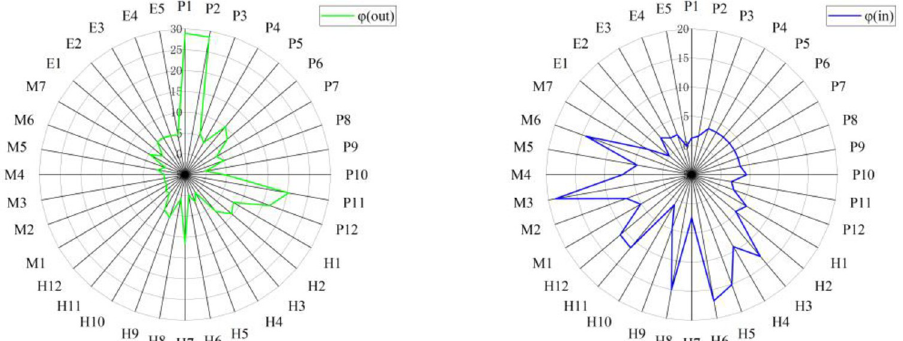
Fig 6. The out-degree and in-degree topological potentials with σ opt =